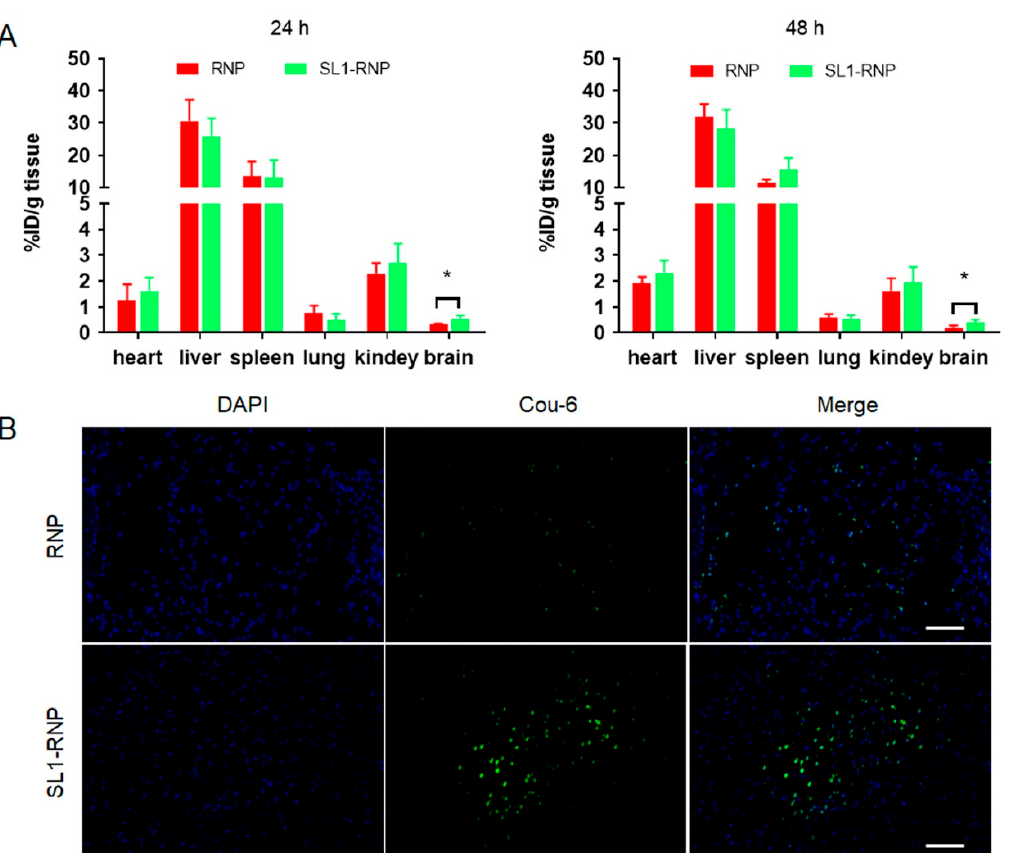
Figure 6. The distribution of SL1 − RNP in glioblastoma-bearing nude mice. The biodistribution of SL1 − RNP at ( A ) 24 h and 48 h after intravenous injection ( n = 6). ( B ) Representative fluorescence images of glioblastoma tissue slices treated with Coumarin 6 − labelled SL1 − RNP or RNP (green) at 24 h after intravenous injection (scale bar = 400 μ m). * p < 0.05.